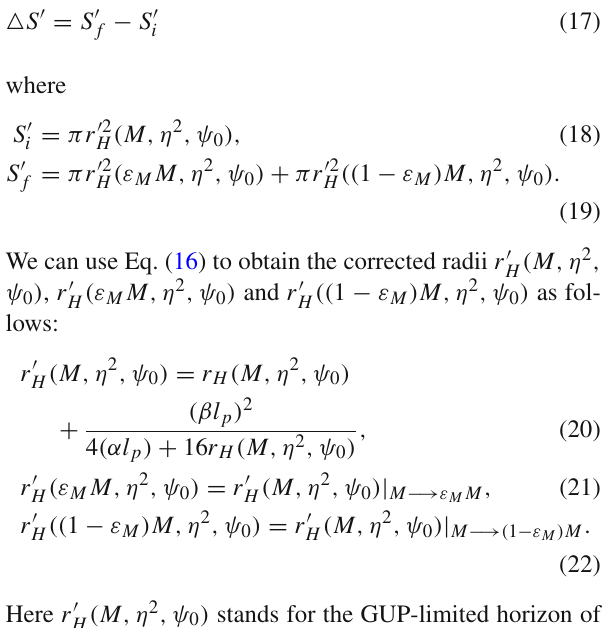
be two roots ε M 0 and 1 − ε M 0 from (cid:4) S (cid:7) = 0. If ε M < ε M 0 or ε M > 1 − ε M 0 , then (cid:4) S (cid:7) > 0, which means that the